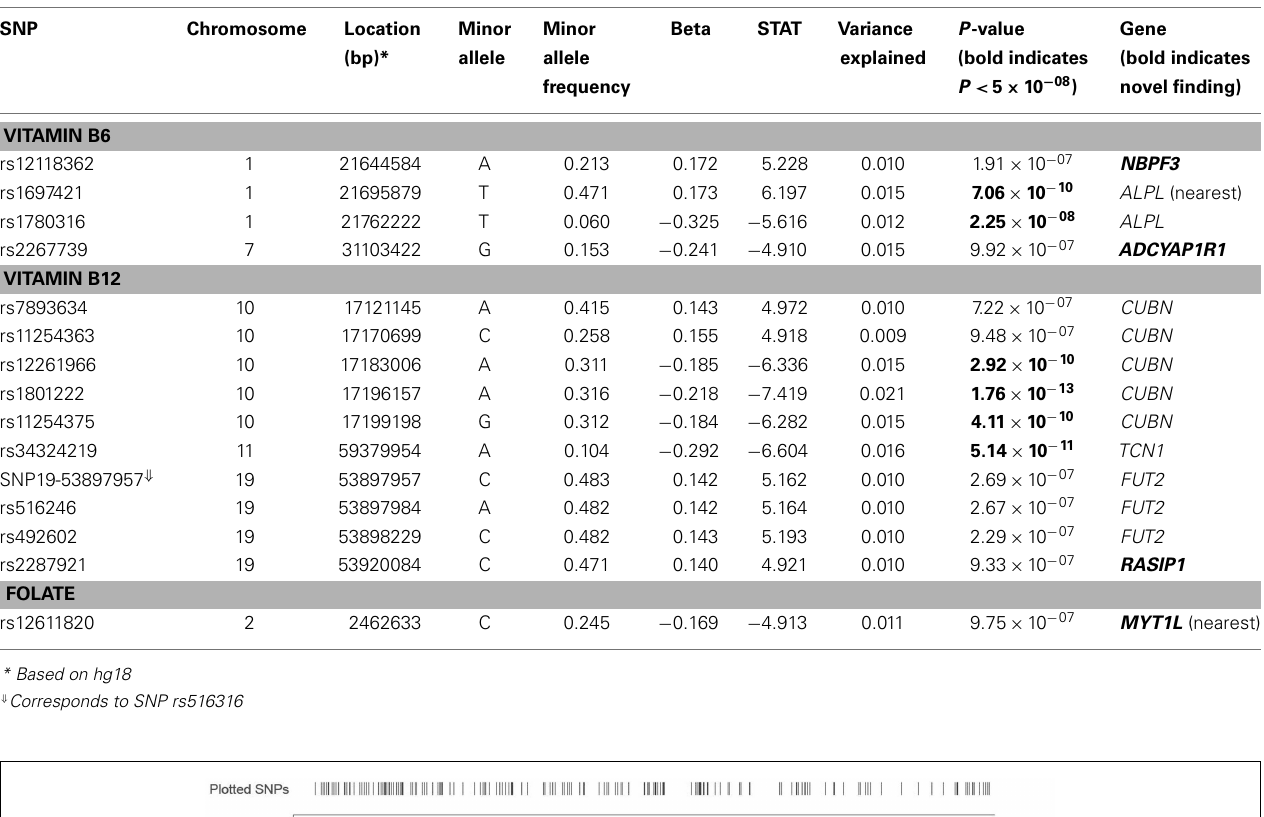
Table 2 |Association results for SNPs with genome-wide ( P ≤ 5 × 10 − 08 ) significance or suggestive evidence ( P ≤ 10 − 07 ) for association .